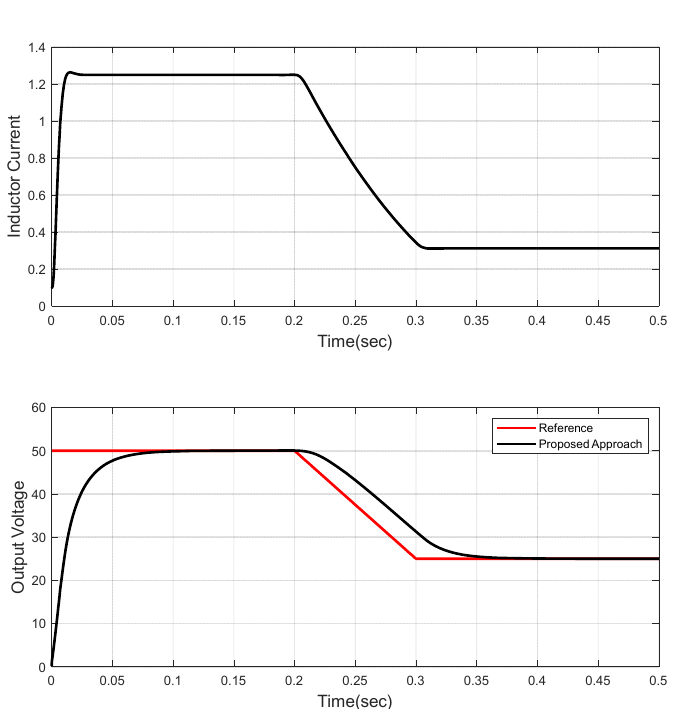
Figure 31. Adaptation gain.